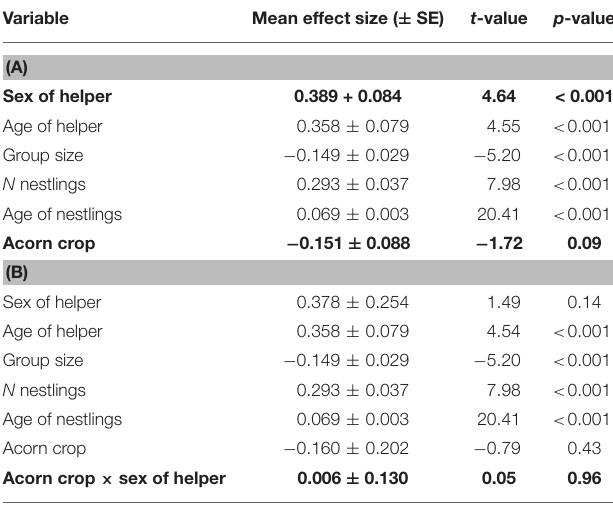
TABLE 2 | Linear regressions of factors influencing feeding rate of helpers (A) without the interaction between number of helpers and the acorn crop and (B) including this interaction.